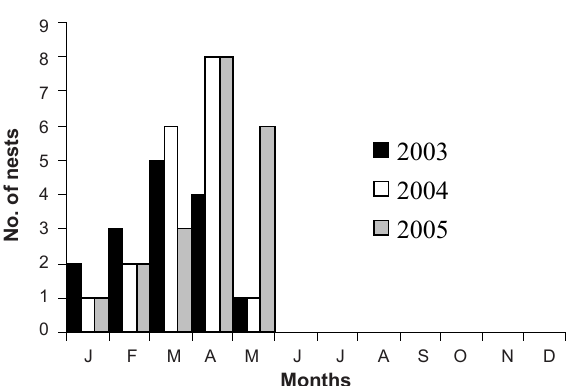
Figure 1. Breeding season of Grey-headed Bulbul based on the number of clutches initiated per month during